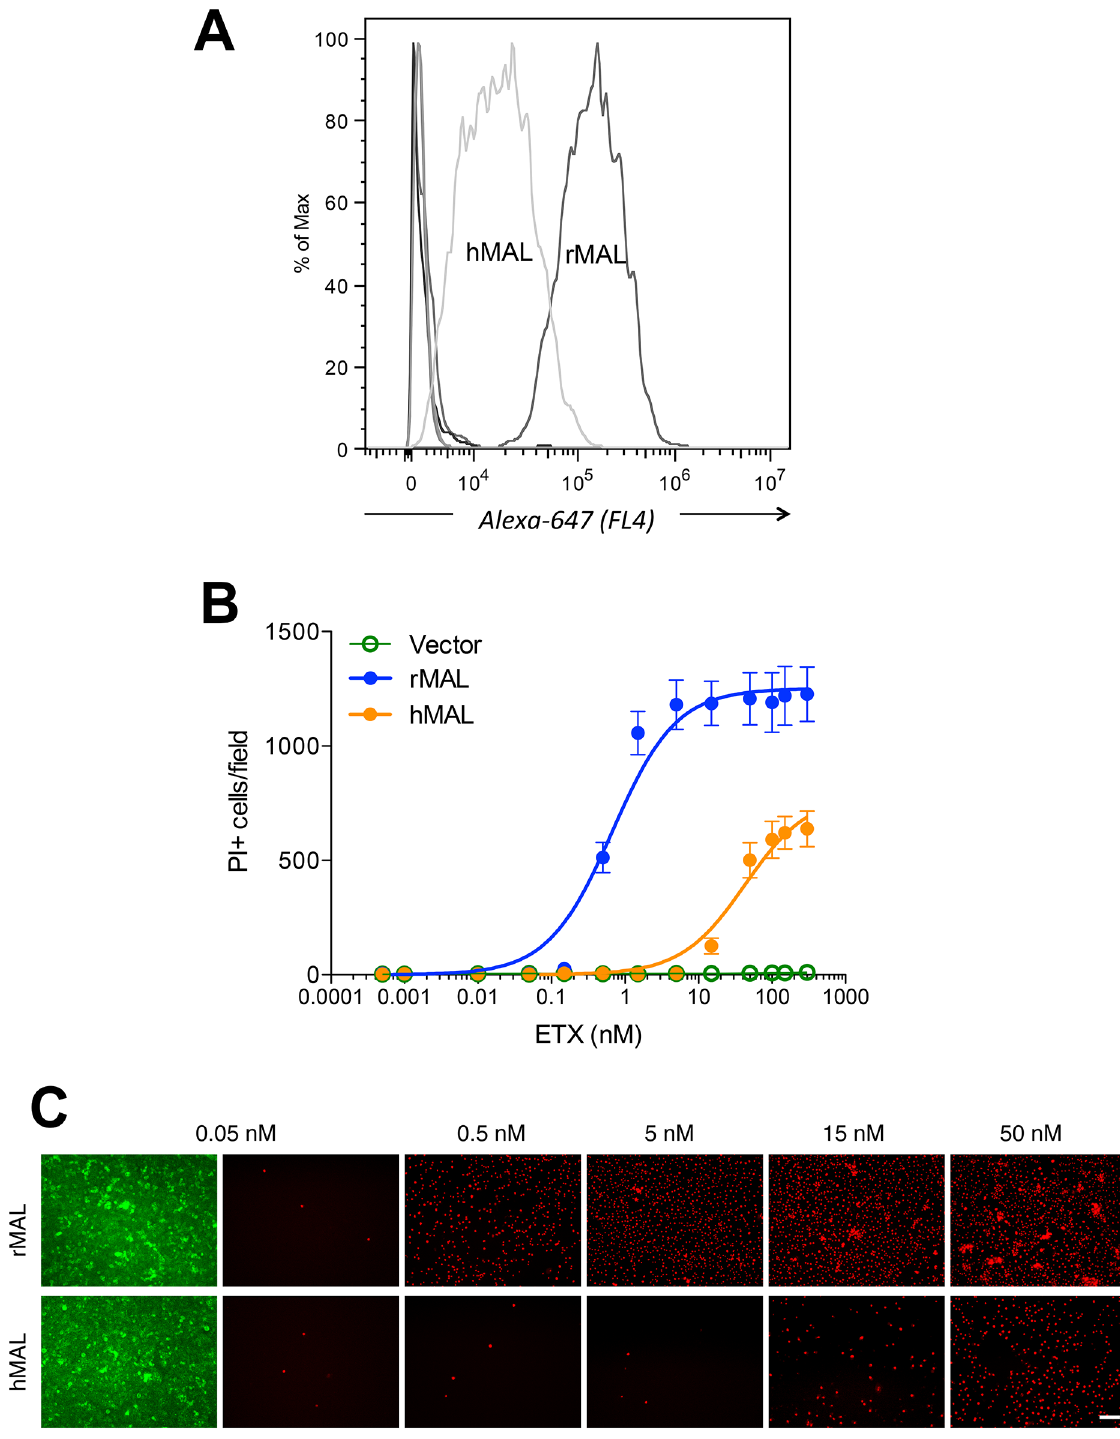
Fig 4. Differential binding and cytotoxicity of ETX to cells expressing MAL orthologues. ( A ) FACS histogram of Alexa 647-labeled ETX binding to cells transiently transfected with MAL expression vectors. As shown, ETX binds to cells expressing rMAL with greater affinity than to hMAL, whereas it fails to bind to CHO cells transiently transfected with constructs expressing zebrafish MAL, hMAL-L2F, or the GFP vector alone (overlapping curves at far left of the plot). ( B ) CHO cells stably expressing GFP-alone (vector), GFP-rMAL (rMAL), or GFP-hMAL (hMAL) were treated with ETX at concentrations ranging from 0 to 300 nM in the presence of 2 μ g/ml PI (red) for 6 hours and live-imaged for assessing cell death. ( C ) Representative images show the ETX effect in GFP-rMAL